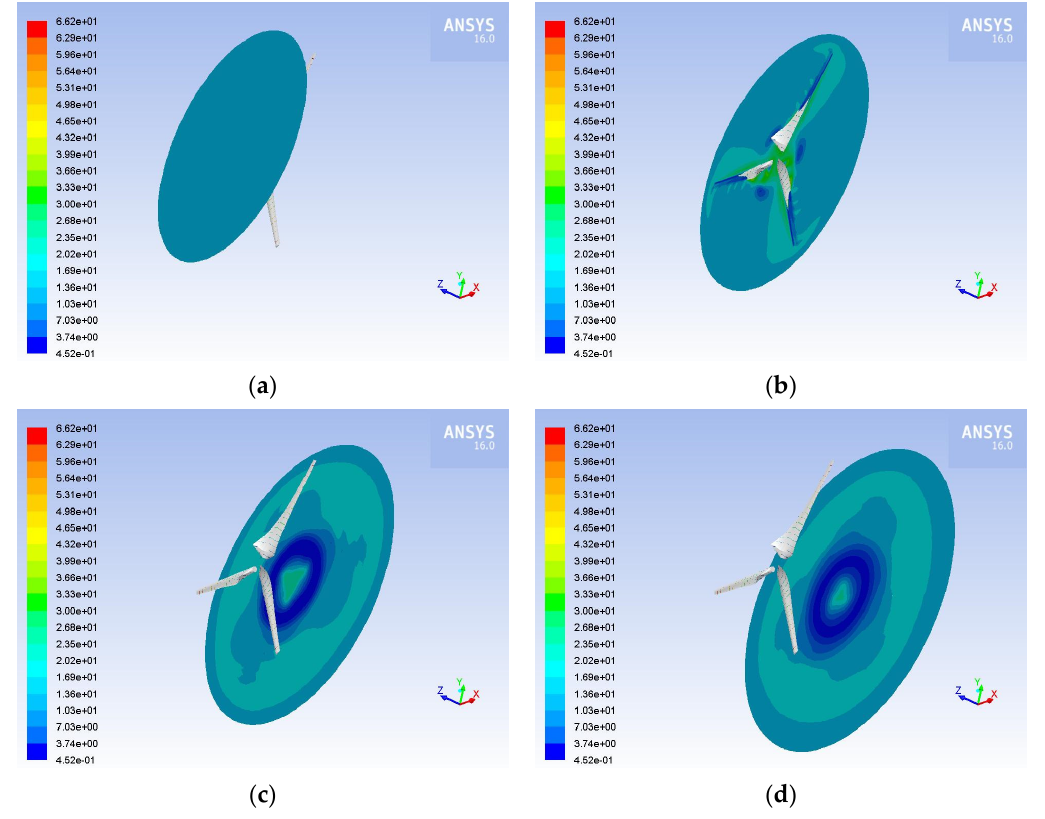
Figure 10. Contours of velocity at ( a ) − 15 m; ( b ) 0 m; ( c ) 15 m; ( d ) 30 m from the three-bladed HAWT rotor for hailstorm conditions and air velocity equal to 15 m·s − 1 . On Figures 11 and 12 the contours of static pressure on both sides of the HAWT blade are demonstrated, for hailstorms and for air velocities of 10 m · s − 1 and 15 m · s − 1, respectively. The static pressure distribution on the blade is similar to the corresponding results for airflow, with the only difference being the range of values, which is limited compared to the airflow results, but the range increases with increasing air velocity.